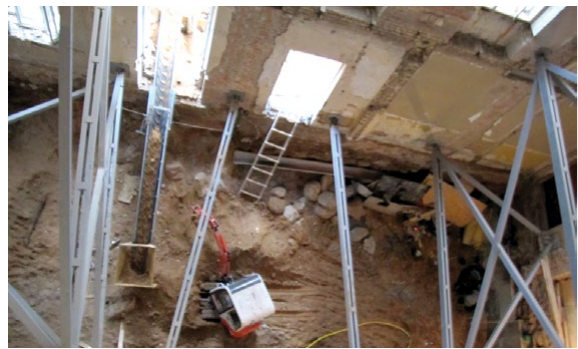
Fig. 8. Strutted walls above deepened